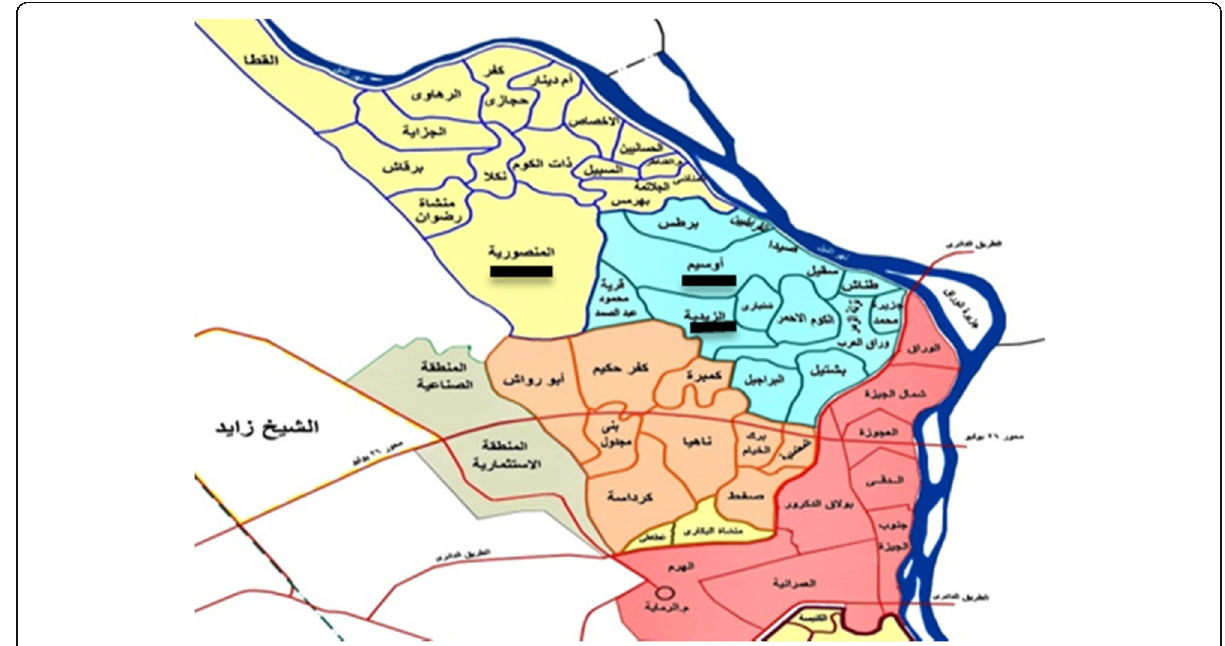
Fig. 1 Shows map of Giza;